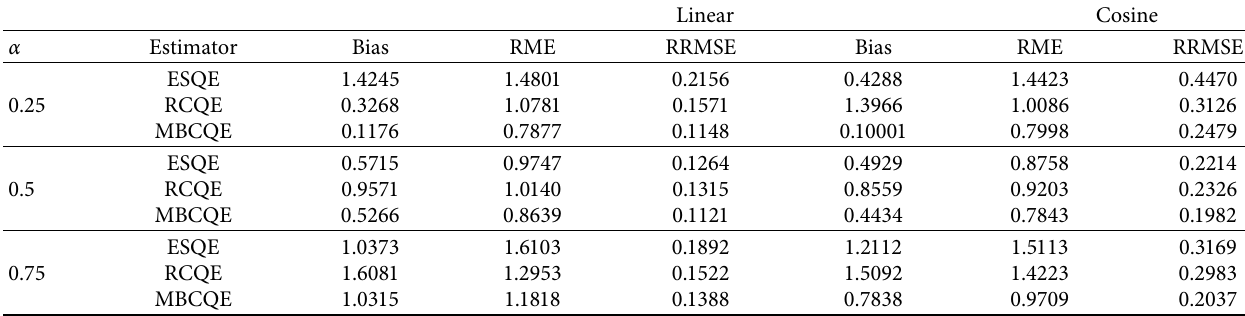
Table 1: Unconditional biases, relative mean errors, and relative root-mean-squared errors.